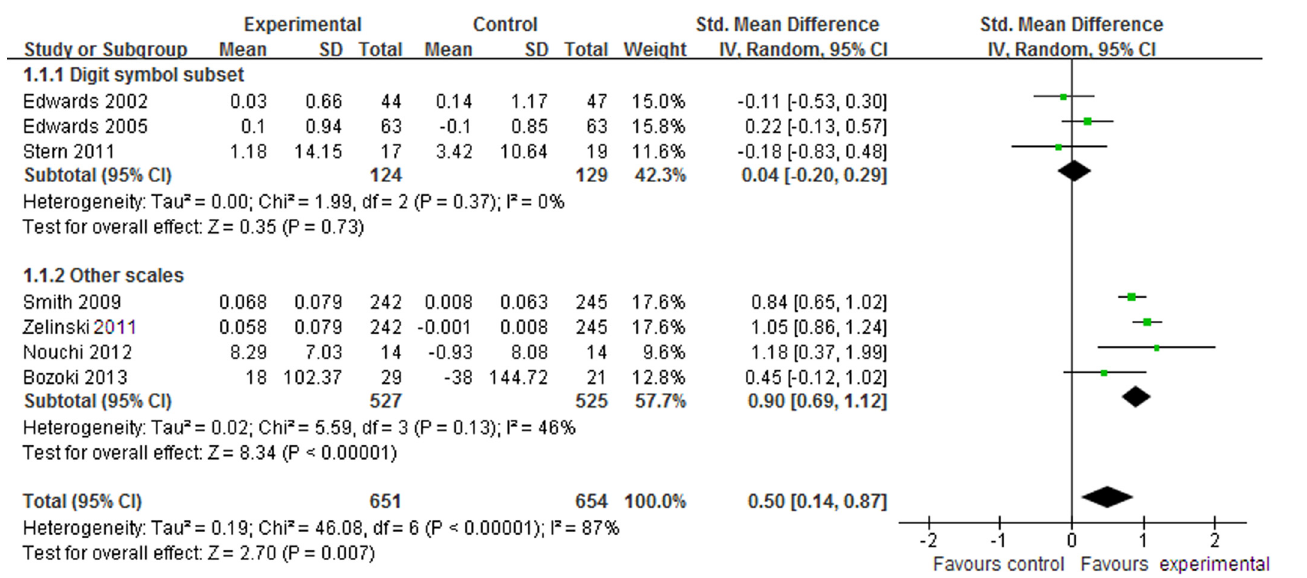
Fig 4. Forest plot of the effect of computer-based cognitive programs in processing speed.